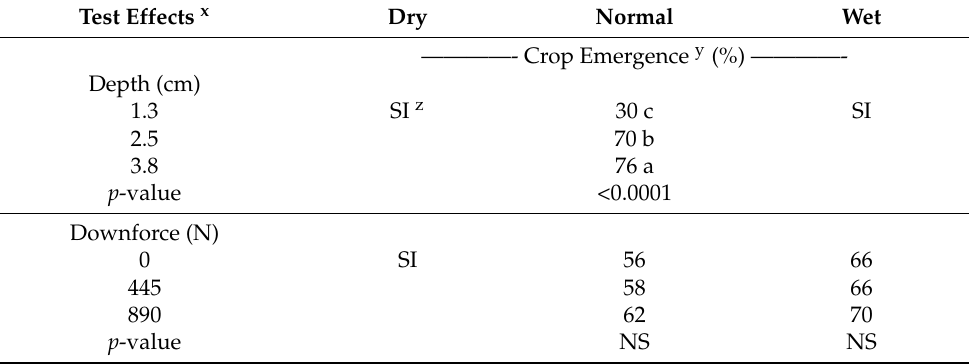
Table 8. Influence of seeding depth, downforce, cultivar, depth × cultivar, and downforce × cultivar on crop emergence in different at-plant field conditions in